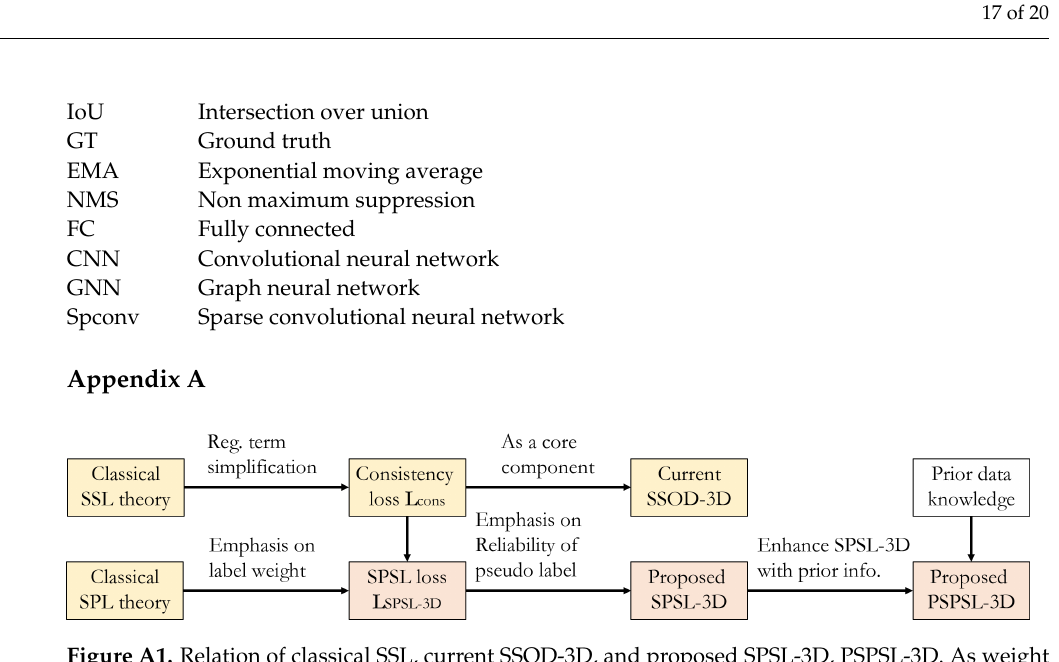
Figure A1. Relation of classical SSL, current SSOD-3D, and proposed SPSL-3D, PSPSL-3D. As weight function w ( x i , x j ) is difficult to design in complex traffic scenarios, the regularization (reg.) term (cid:107) w (cid:107) I in traditional SSL theory is simplified as the consistency loss L cons . In this paper, emphasising the impact of the reliability of pseudo labels on SSOD-3D training, we present SPL-based consistency loss L SPSL-3D and SPSL-3D. Prior information (info.) is exploited to enhance the effect of SPL on